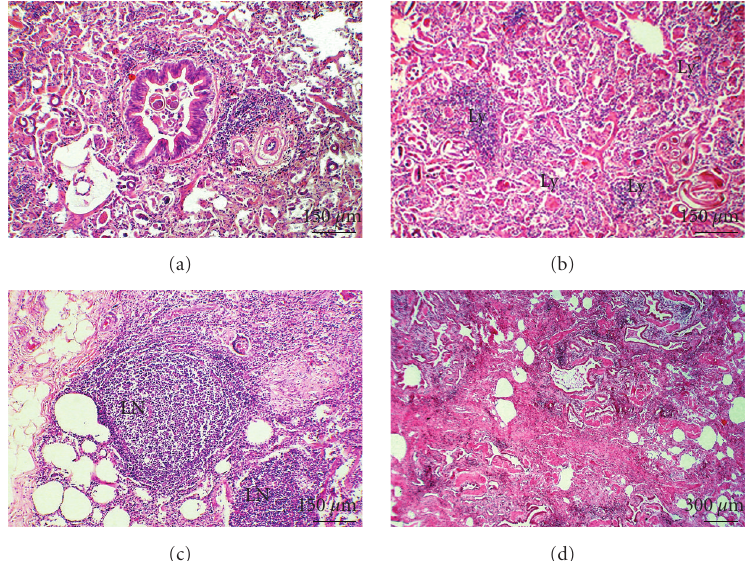
Figure 4: Sheep, lungs, infected with protostrongylids. (a) A nodule with M. capillaris . Peribronchial lymphoid hyperplasia. (b) A lobular lesion with P. hobmaieri . Disseminated lymphoid hyperplasia (Ly). (c) A lobular lesion with P. hobmaieri . Intralobular lymphoid hyperplasia, formation of lymphoid nodules (LNs). (d) A lobular lesion with M. capillaris . Sclerosis of the parenchyma with a lymphocyte infiltration of the sclerotic